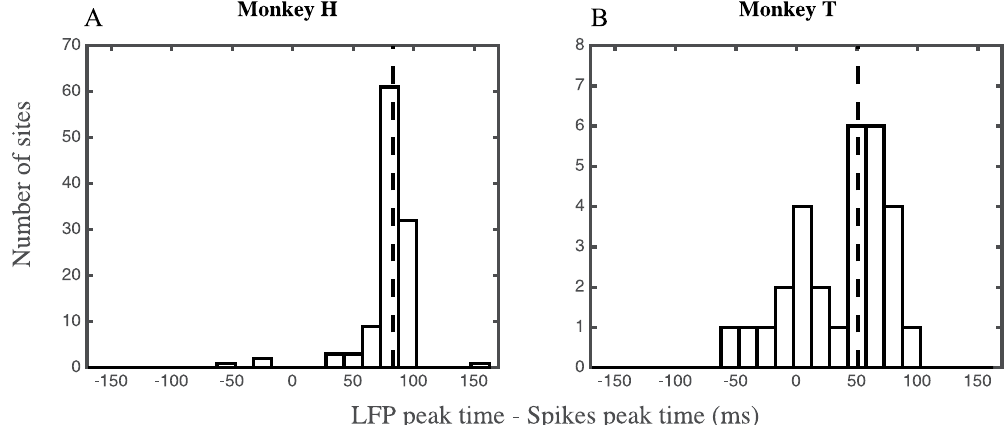
Figure 2. Spiking activity and LFP peak time relative to each other. ( A , B ) Each panel shows the histogram of latencies between spiking activity and LFP peaks for one monkey across recording sites. The dashed lines represent the median latencies; which are positive for both